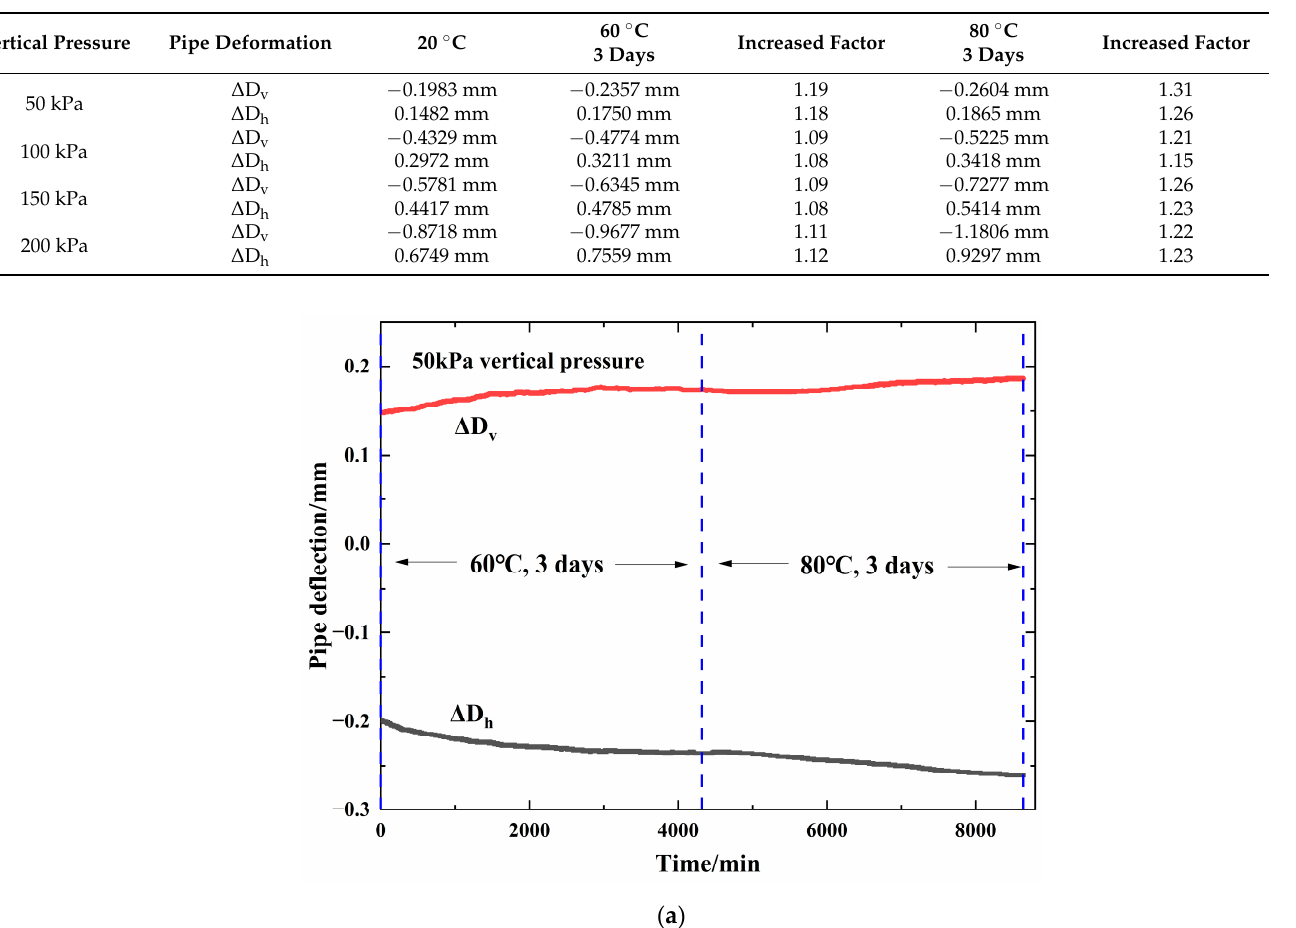
Table 4. The creep measurements of the HDPE pipe in the duration of the test.